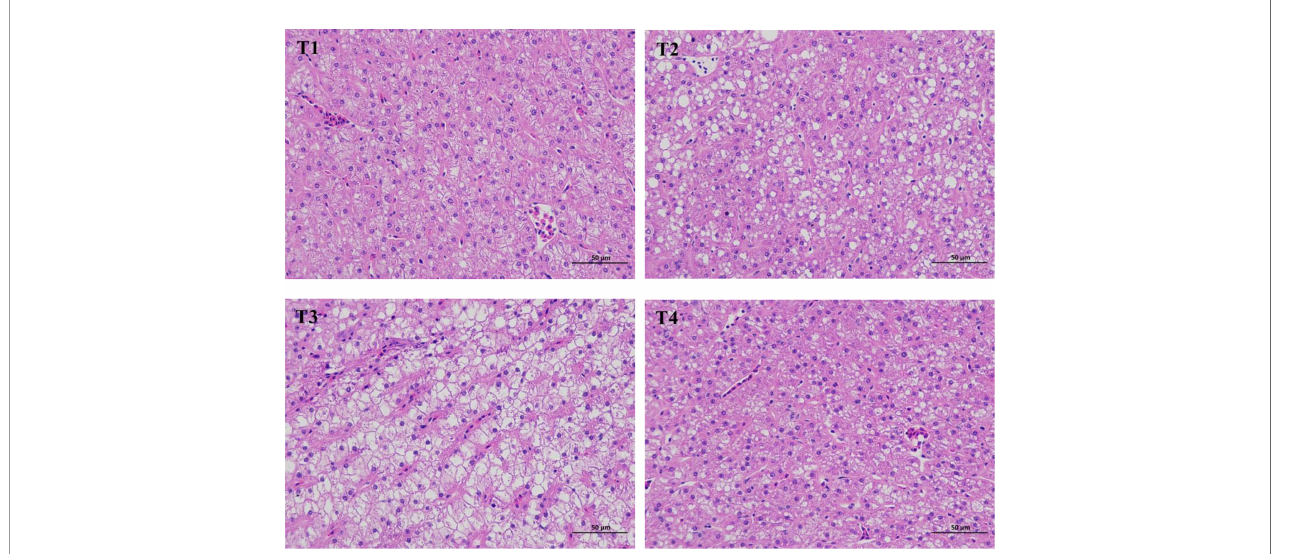
FIGURE 1 | Liver histomorphology (haematoxylin-eosin stain, × 400) of L. maculatus fed experimental diets. T1, basal diet; T2, basal diet supplemented with 1 g/kg of condensed tannins; T3, basal diet supplemented with 2 g/kg of condensed tannins; T4, basal diet supplemented with 2 g/kg of condensed tannins and 4 g/kg of polyethylene